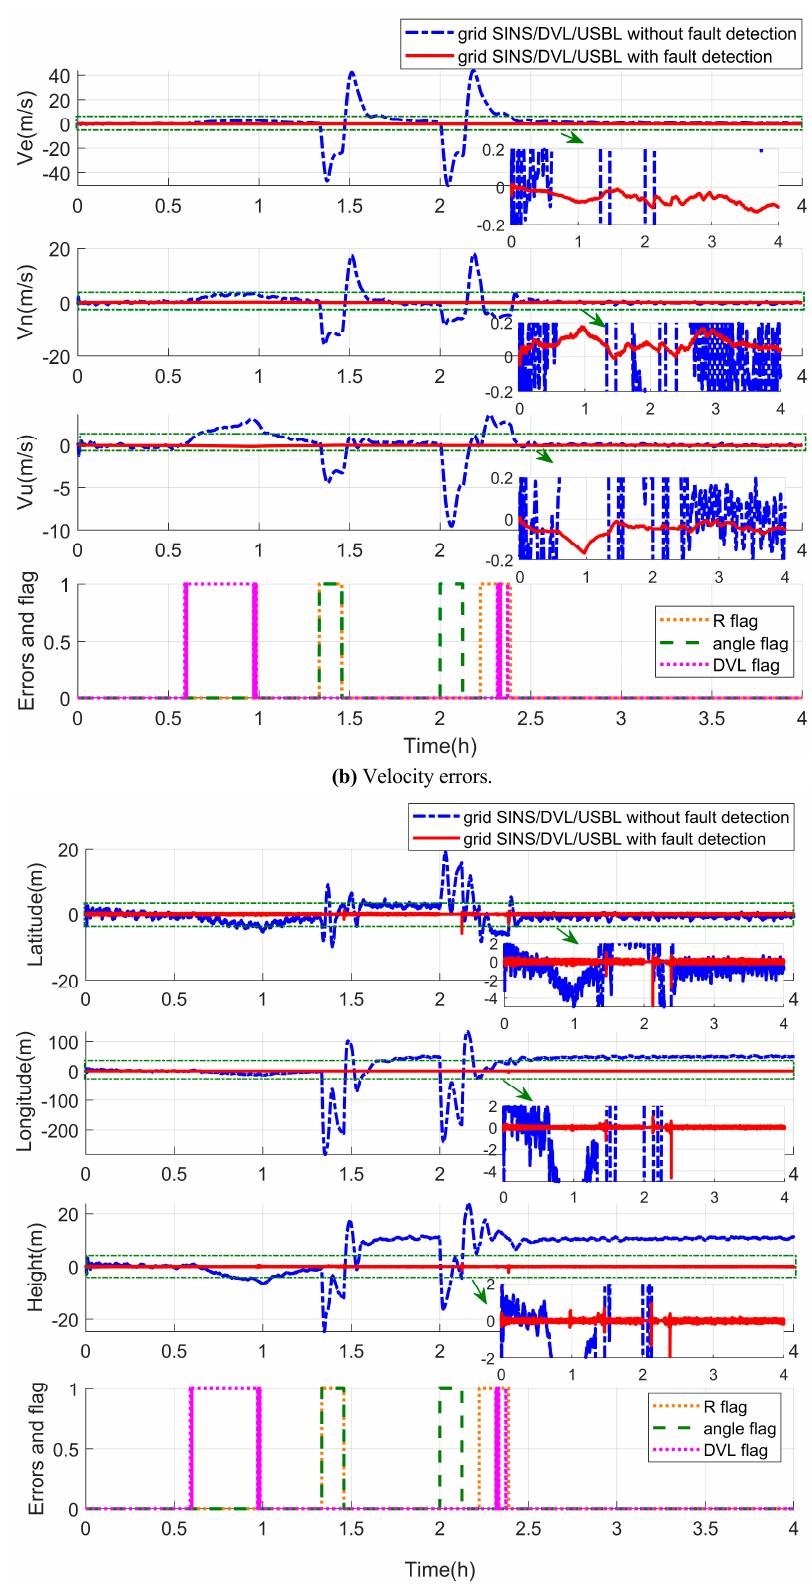
Figure 14. Description of the grid SINS / DVL / USBL integrated navigation errors with and without the fault